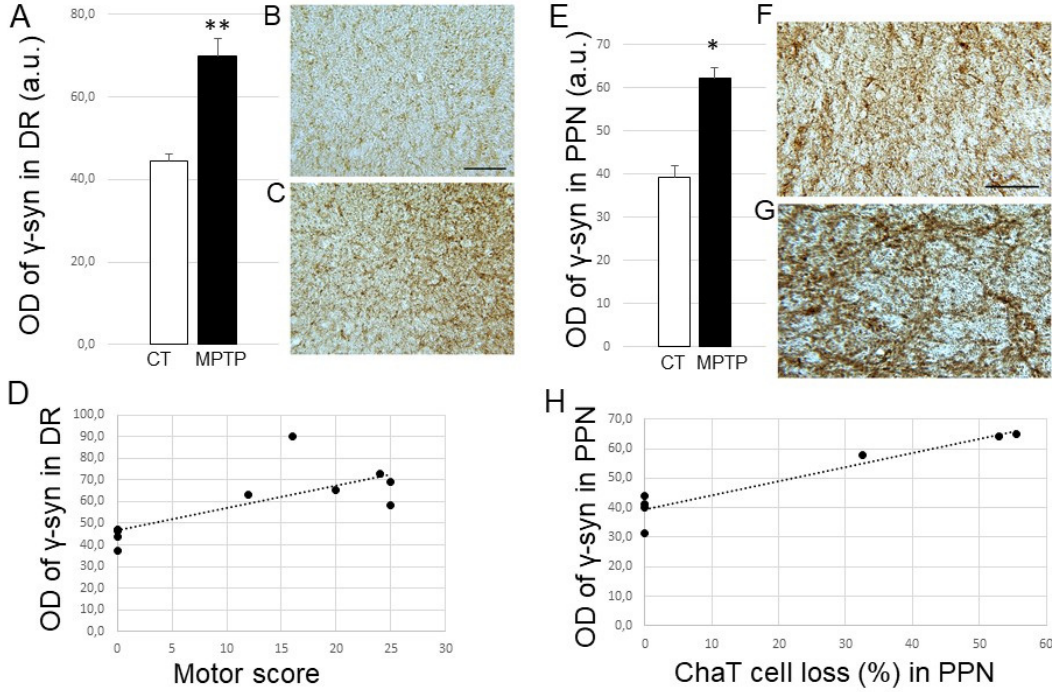
Figure 5. ( A ) Histogram represents optical density of γ -syn (in arbitrary units) in DR from control (CT, n = 5) and MPTP-intoxicated (MPTP, n = 6) animals. ** p < 0.01 when compared to controls. ( B , C ) Photomicrographs at high magnification ( × 16) of coronal sections of a control (MF14) and an MPTP-intoxicated (MF18) Macaca fascicularis, exemplifying γ -syn labeling obtained at the level of the dorsal raphe. Scale bar on B is 100 µ m. ( D ) Positive correlation observed between the expression levels of γ -syn (OD expressed in arbitrary units) in DR and the maximal motor score exhibited by the monkeys. ( E ) Histogram represents optical density of γ -syn (in arbitrary units) in PPN from control (CT, n = 4) and MPTP-intoxicated (MPTP, n = 3) animals. * p < 0.05 when compared to controls. ( F , G ) Photomicrographs at high magnification ( × 16) of coronal sections of a control (MF14) and an MPTP-intoxicated (MF16) Macaca fascicularis, exemplifying γ -syn labeling obtained at the level of the pedunculopontine nucleus. Scale bar on F is 100 µ m. ( H ). Positive correlation observed between the expression levels of γ -syn (OD expressed in arbitrary units) and the percentage of ChaT cell loss in PPN. Abbreviations: a.u, arbitrary units; OD, optical density; DR, dorsal raphe; CT, control; PPN, pedunculopontine nucleus.